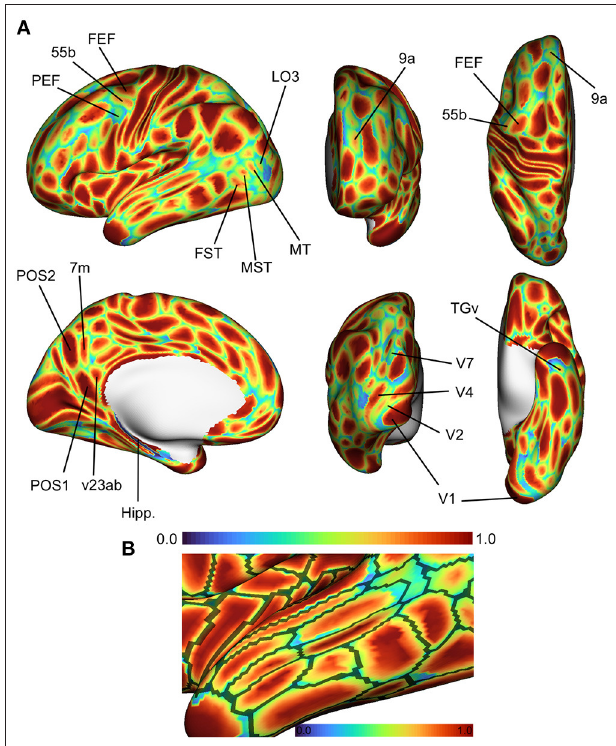
FIGURE 4 | Average accuracy maps for the HCP test set using the optimal model, computed by averaging the classification error maps across all HCP dataset test subjects. (A) Blue (0.0) = vertex incorrectly classified in all test subjects; Red (1.0) = vertex correctly classified in all test subjects. Areas in the lateral prefrontal and ventral/dorsal occipital areas showed the highest error rates. (B) Errors occur most frequently at the boundaries of cortical regions. Black lines represent areal boundaries of the consensus prediction